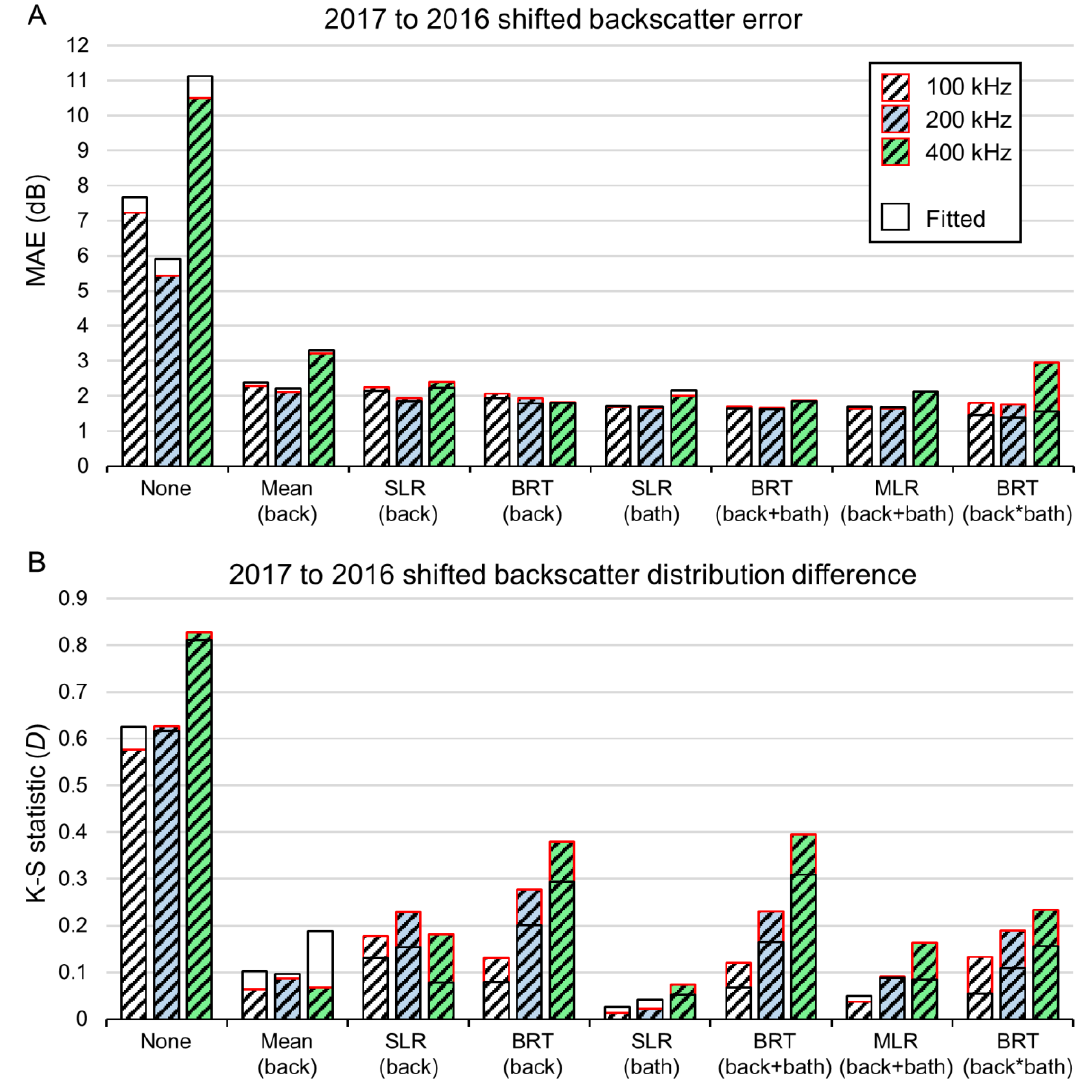
Figure 6. ( a ) Fitted and test mean absolute errors (MAEs) of 2017 Bedford Basin data corrected to 2016 for 100, 200, and 400 kHz frequencies with seven bulk shift methods, and ( b ) Kolmogorov–Smirnov (K-S) statistics for distributions of 2016 Bedford Basin data compared with shifted 2017 frequencies.